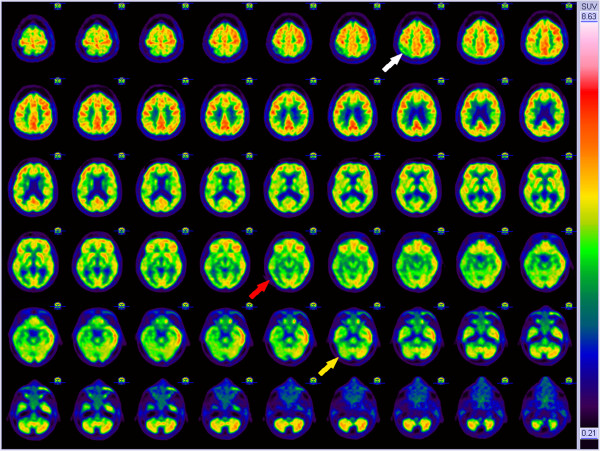
18 F-fluoro-deoxy-glucose positron emission tomography scan of the brain (transverse images). There was a non-specific pattern of hypometabolism of the right parietal cortex (white arrow) and temporal cortex (red arrow) as well as hypometabolism of the right cerebellar hemisphere (yellow arrow). The latter could not be explained by crossed cerebellar diaschisis as in that case the left cerebellar hemisphere would have shown a hypometabolic pattern.